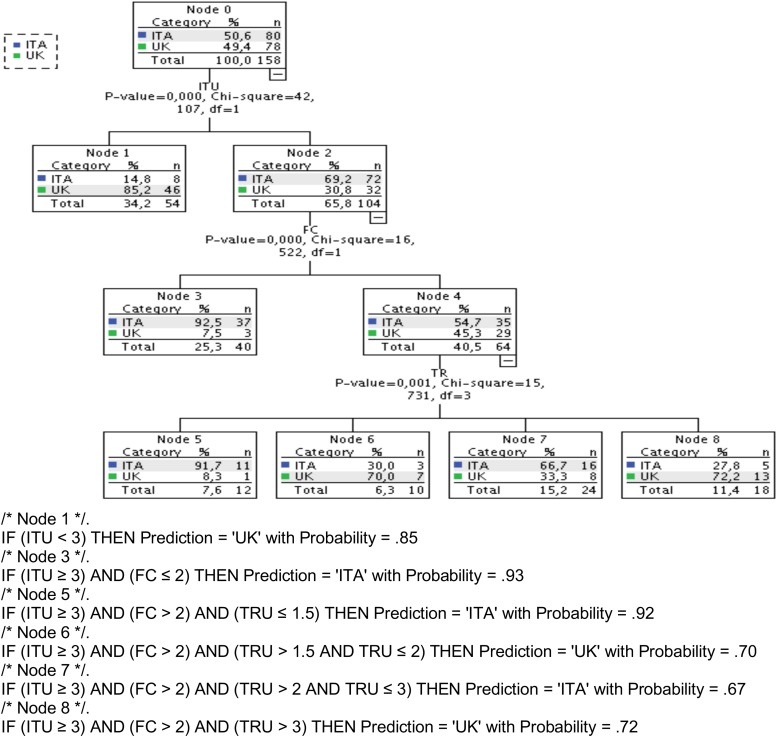
Decision Tree diagram and classification rules for final nodes.